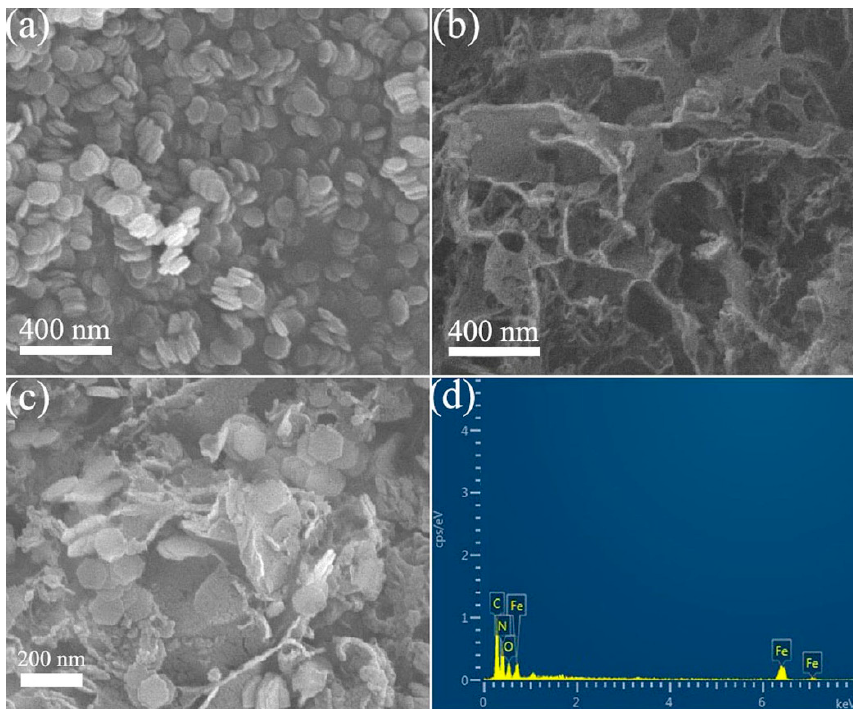
Figure 2. SEM images of different samples: ( a ) 2D α -Fe 2 O 3 , ( b ) 2D g-C 3 N 4 , ( c ) 5 wt.% α -Fe 2 O 3 @g-C 3 N 4 photocatalyst and ( d ) EDS of 5 wt.% α -Fe 2 O 3 @g-C 3 N 4 photocatalyst.